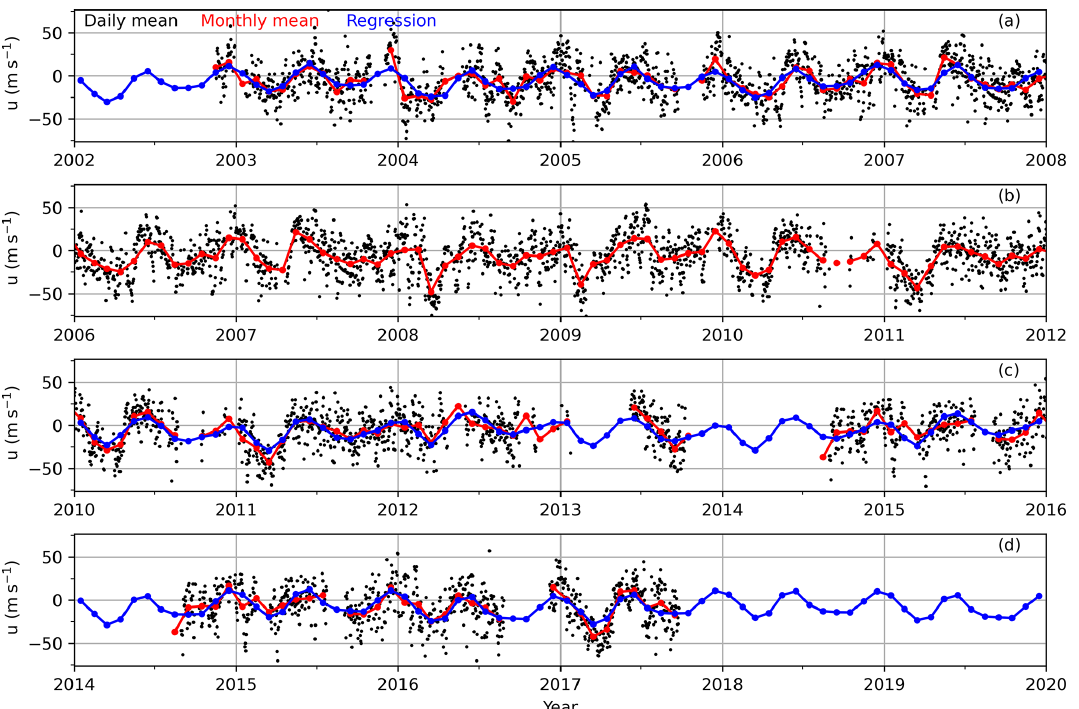
Figure 1. The daily mean (black dots) and monthly mean (red line with dots) zonal winds (positive for eastward) at 86km measured by the KT (Koto Tabang) meteor radar and their regression results (blue line with dots) from 2002 to 2019. The ticks on the x axis mark the beginning of each